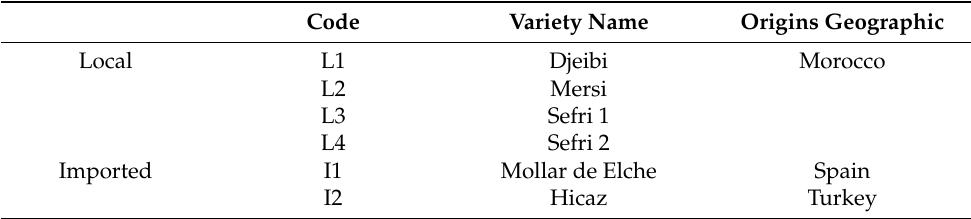
Table 9. Origins geographic of the six pomegranate commercial cultivars collected.